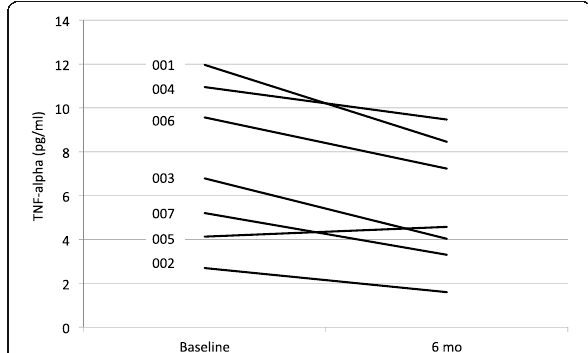
Fig. 3 Change in TNF levels from baseline to 26 weeks while on transcutaneous vagus nerve stimulation